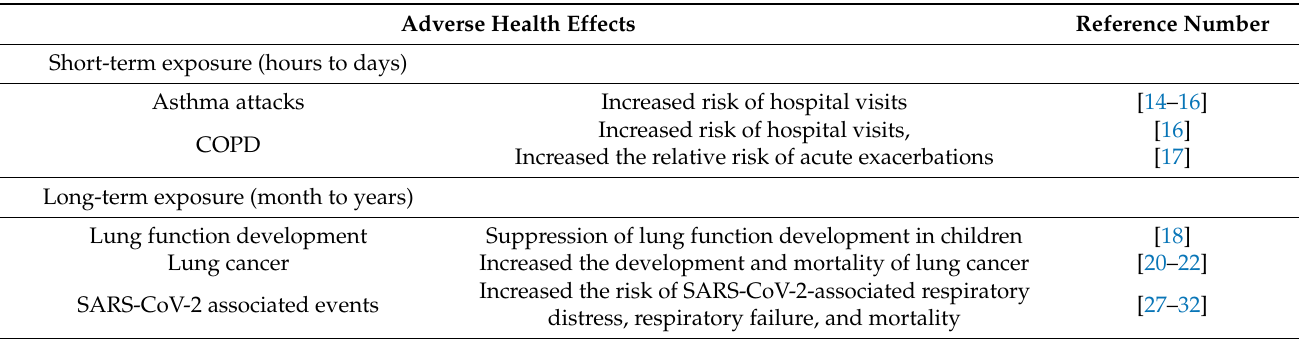
Table 1. Health hazards to the respiratory system of PM 2.5